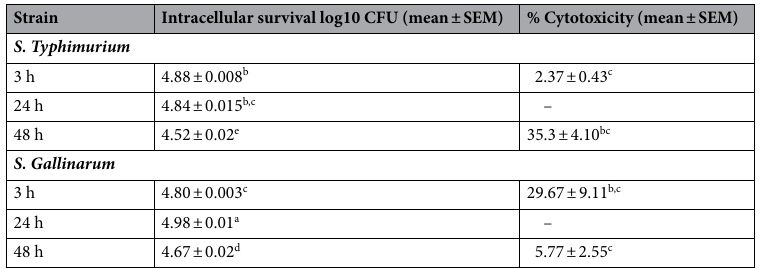
Table 1. Intracellular survival and cytotoxicity % of S . Gallinarum and S . Typhimurium in the chicken monocyte derived dendritic cells (chMoDCs). Different superscripts (a, b, c, d, e) across the rows denotes significant difference.